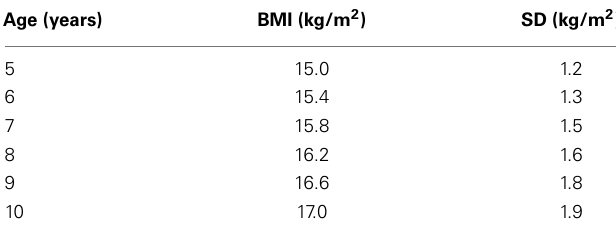
Table 2 | Measured body mass index (BMI) and standard